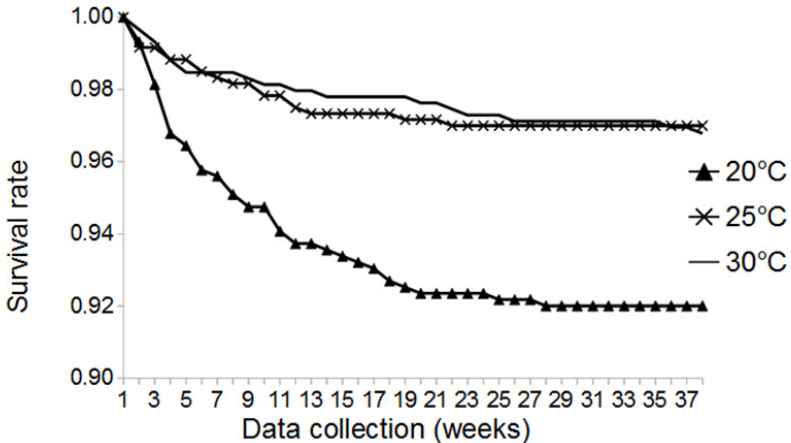
Figure 1. Survival rates (in %) of mealworms at three different temperature regimes (20 °C, 25 °C, and 30 °C).